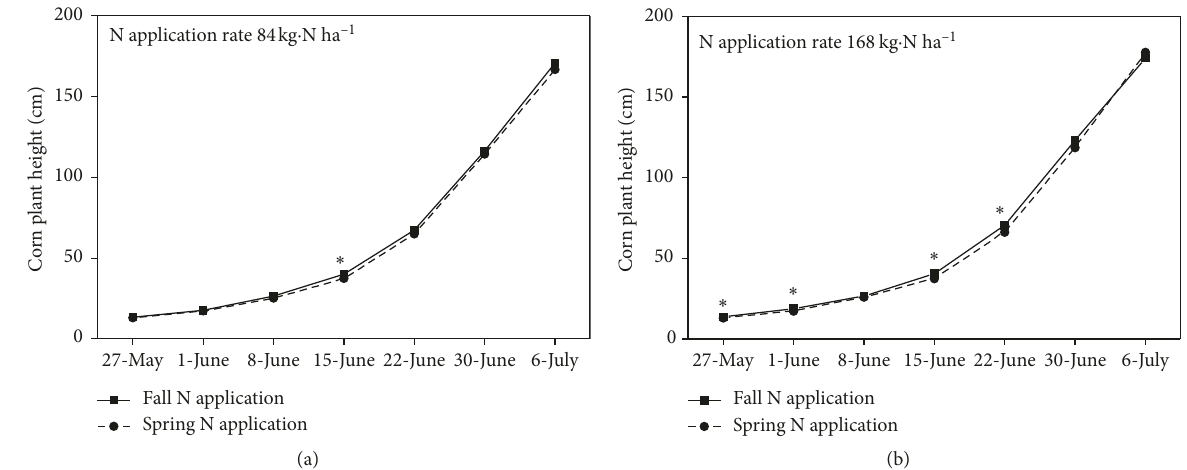
Figure 3: Corn plant heights due to N timing averaged over N source placements and years. Plant heights were measured on selected dates before VTat (a) 84 and (b) 168kg · N · ha − 1 . Asterisks over lines indicate differences among treatments within a given measurement date using Fisher’s Protected LSD ( P ≤ 0 .